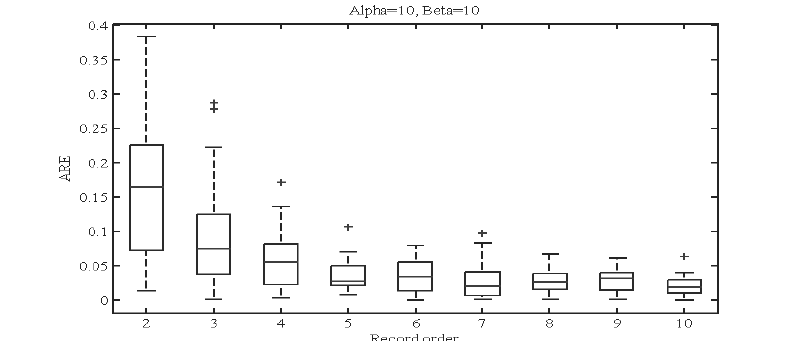
Figure 9 – Skewness coefficient of